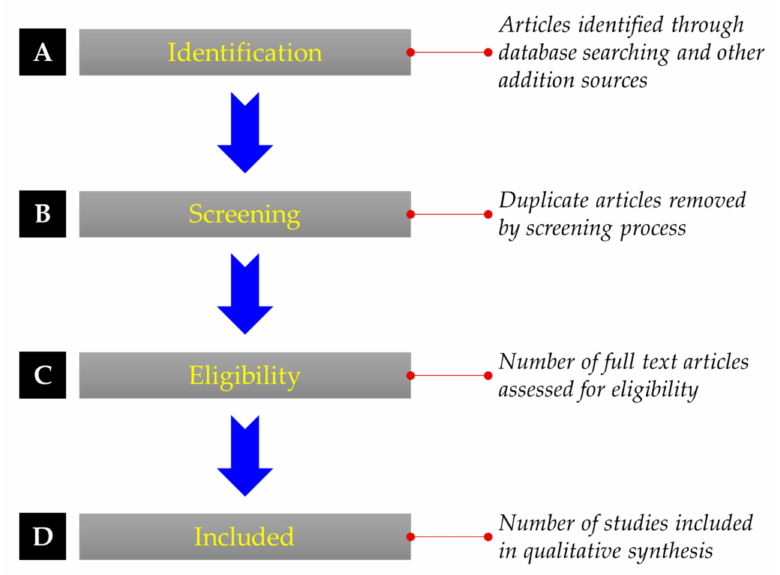
Figure 9. A PRISMA Methodology, reprinted with permission from ref. [61]. Copyright 2009 BMJ Publishing Group